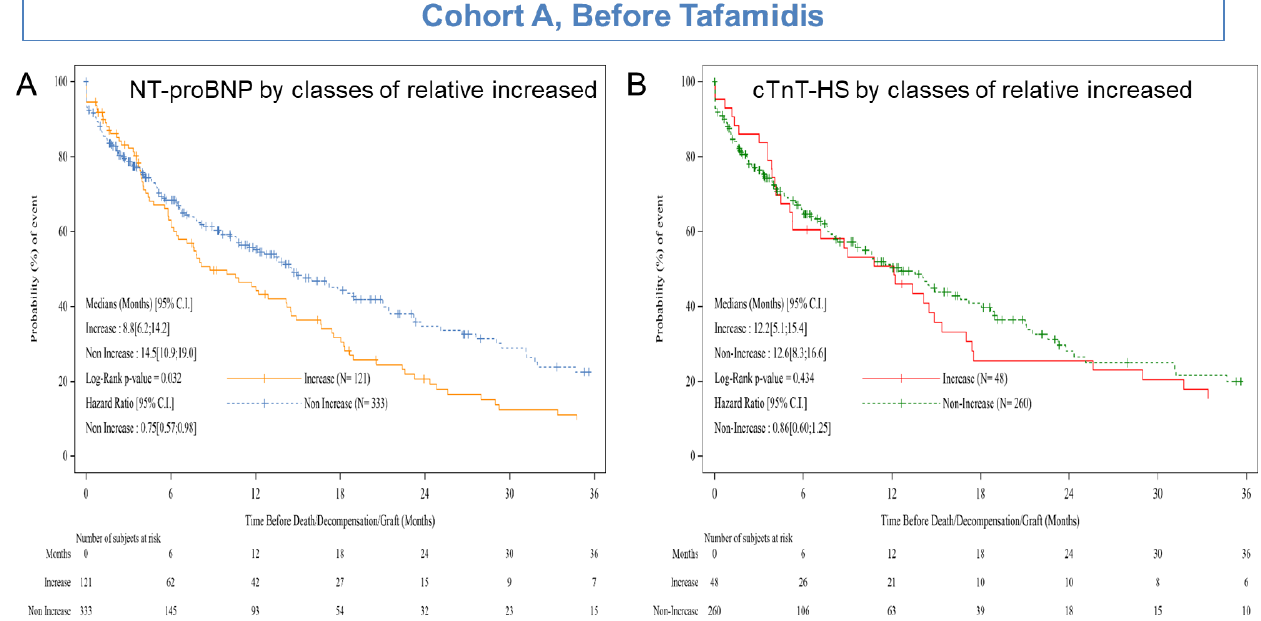
Figure 4. ( A ) Event-free survival by 50% relative evolution of NT-proBNP levels in Cohort A ( n = 454) and ( B ) Event-free survival by 50% relative evolution of cTnT-HS levels in Cohort A ( n = 308).